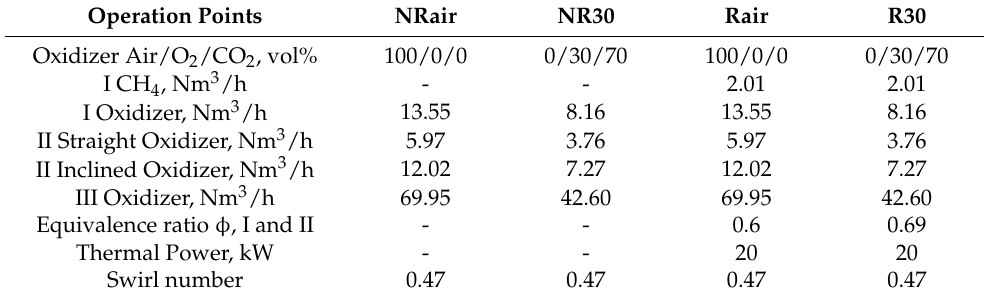
Figure 2. Sectional view of the burner with the combustion chamber and optical equipment for the RTD measurements: ( a ) burner and quarl flows; ( b ) entire combustion chamber with the depiction of gas flame. Reprinted with permission from [47] © The Optical Society. Table 1. Details of the points of operation [52]. Data below reproduced with permission from ref. [52], 2017, Elsevier. Operation